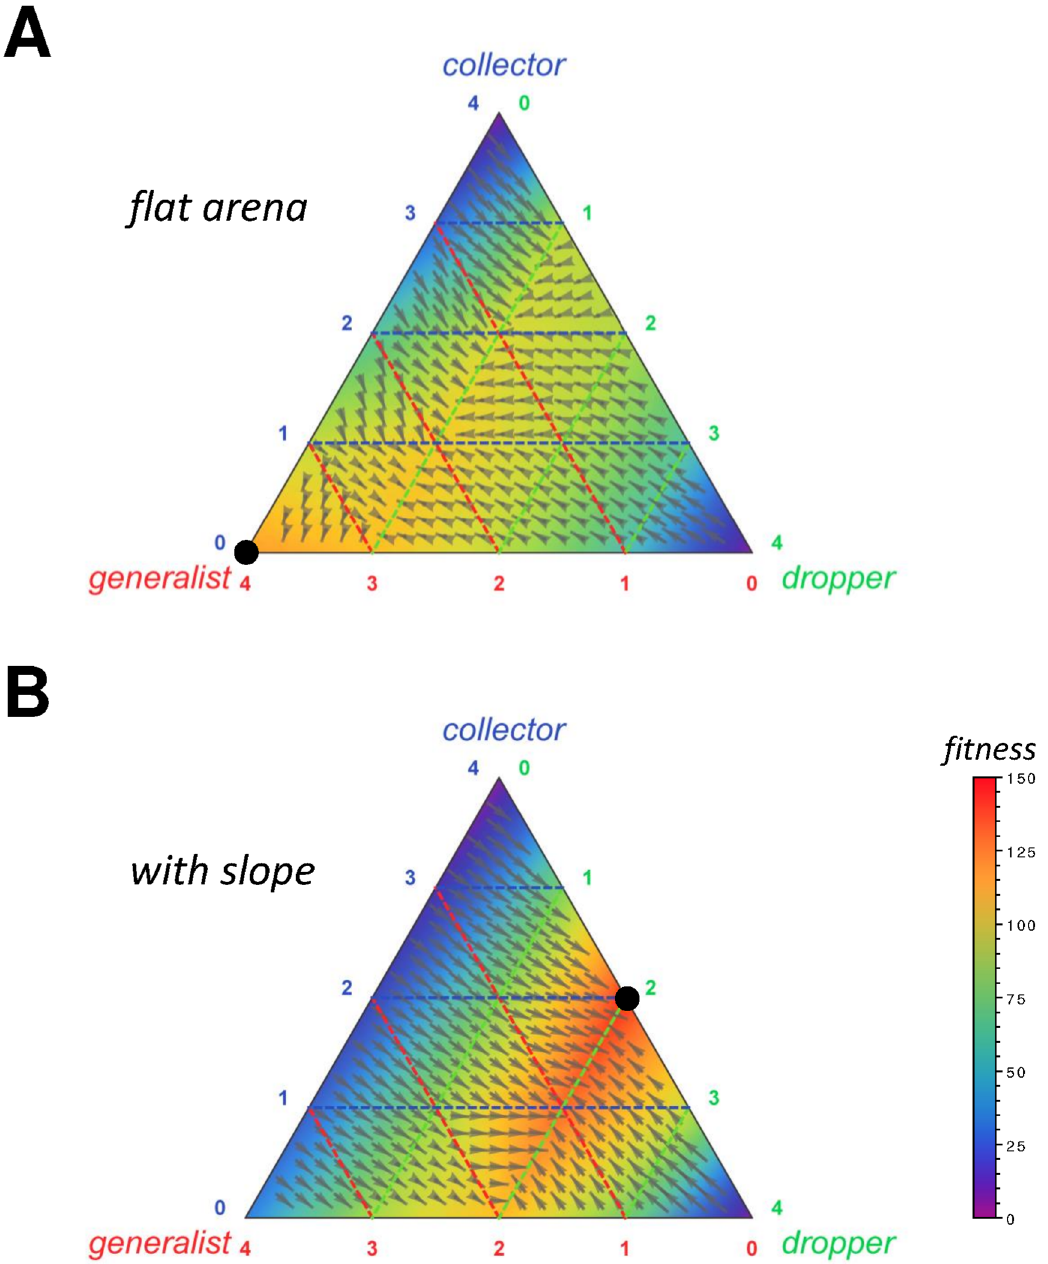
Fig 3. Optimal group composition in 4 robot teams using pre-adapted dropper, collector or generalist foraging strategies (cf. hand-coded rules shown in S1 Table). Ternary plots show group performance (total number of items retrieved to the nest over a period of 5,000 simulated seconds averaged over 10 simulation runs, color coded) as a function of the number of collectors (blue), droppers (green) and generalist foragers (red) in the 4 robot teams (black dot = optimum). In a flat environment (a) , teams of generalist foragers achieve optimal performance (cf. S2 Video), whereas in a sloped arena (b) , a mix of 2 droppers and 2 collectors is most optimal (cf. S1 Video). Both of these optima are global attractors in their respective fitness landscapes (cf. vectors which represent the phase